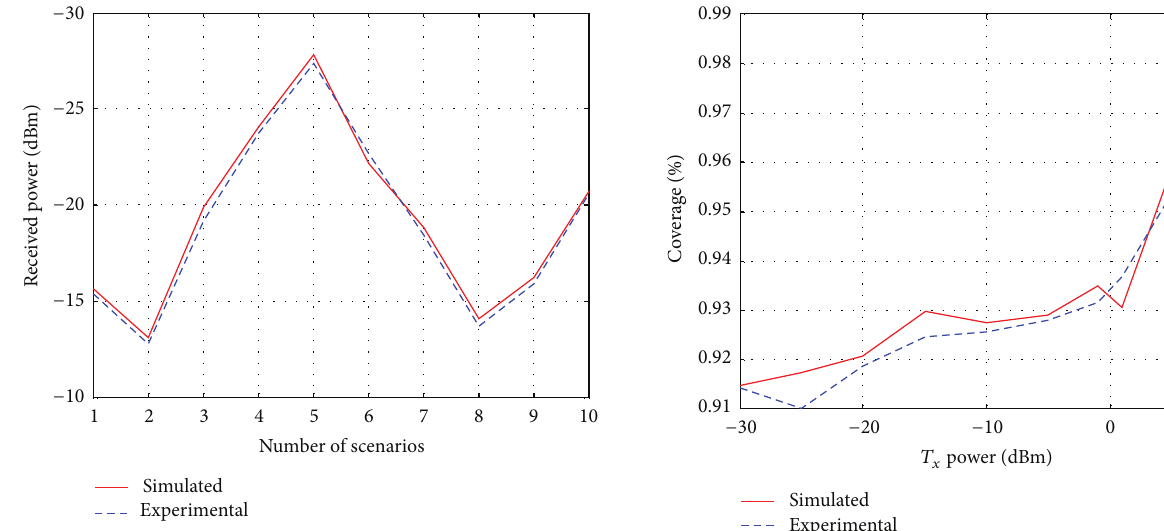
Figure 15: Comparison between simulated and experimental cov-